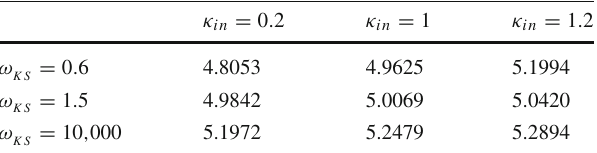
and κ in KS = 1 . 2 ω = 0 . KS KS